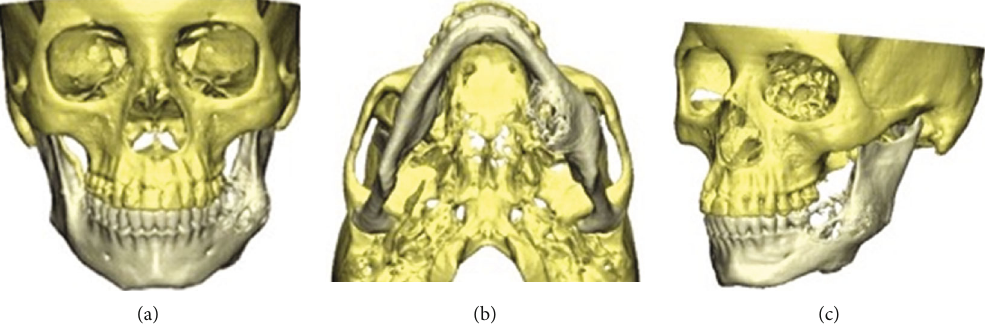
Figure 1: 3D reconstruction showing ameloblastoma. (a) Frontal view. (b) Sagittal view. (c) Axial view.